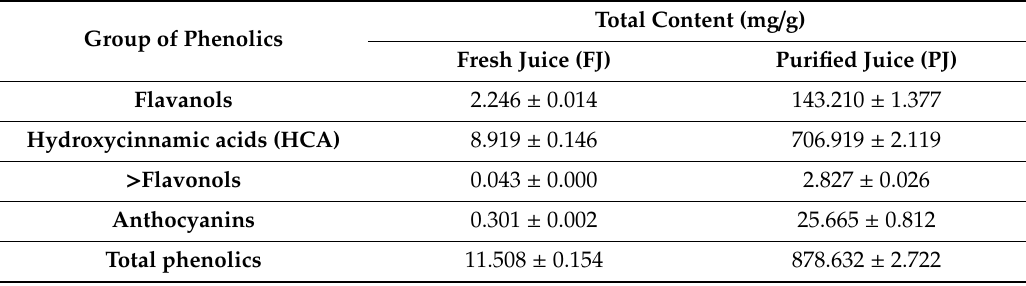
Table 2. The total content of the di ff erent phenolic groups in V. opulus fresh juice and purified juice according to UPLC–PDA-Q / TOF-MS